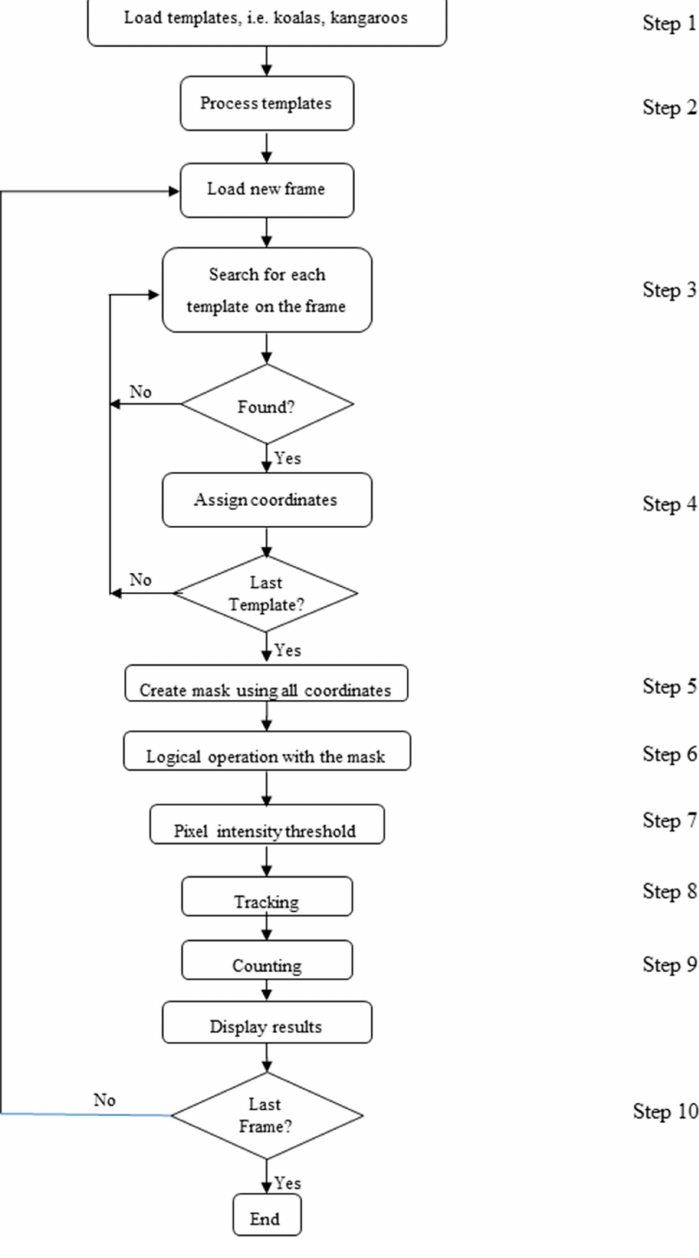
Figure 10. Flowchart Template Matching Binary Mask